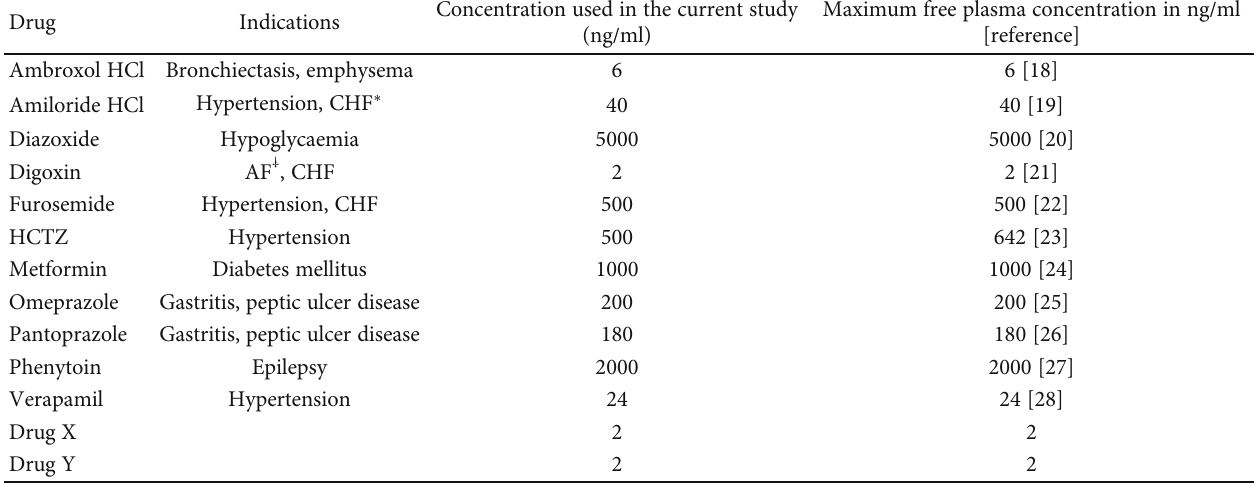
Table 1: Concentrations of the drugs tested in the current study and their maximum free plasma concentrations in humans.